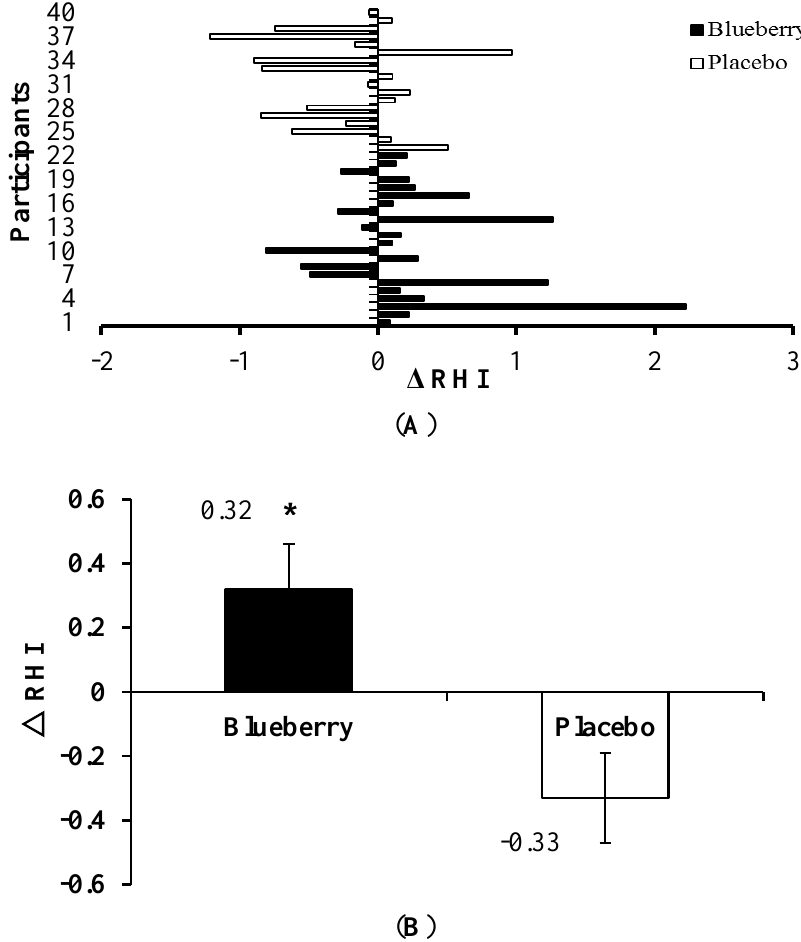
Figure 2. ( A ) Change in RHI (Δ; post- minus pre-intervention) in individual humans with metabolic syndrome who consumed the blueberry or placebo smoothie for six weeks; ( B ) mean change in RHI after adjusting for percentage of body fat and gender. * p = 0.0023 between groups (blueberry versus placebo). RHI, reactive hyperemia index ( i.e ., endothelial function). Values are the means ± SEM, n = 22 (blueberry) or n = 18